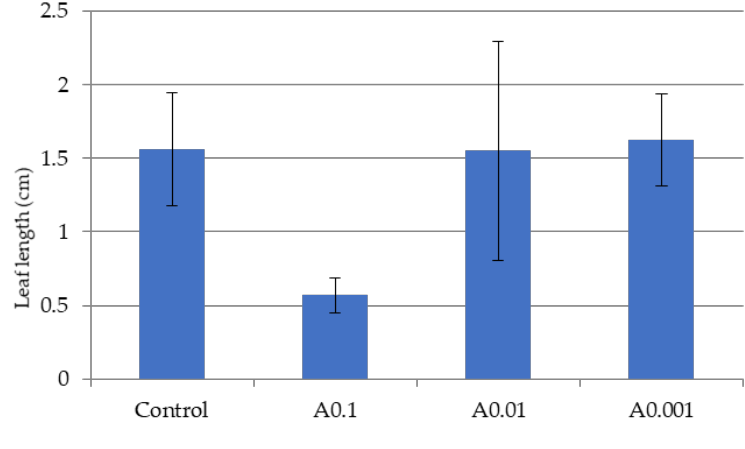
Figure 3. Average leaf length of sorghum after 5 days of exposure.